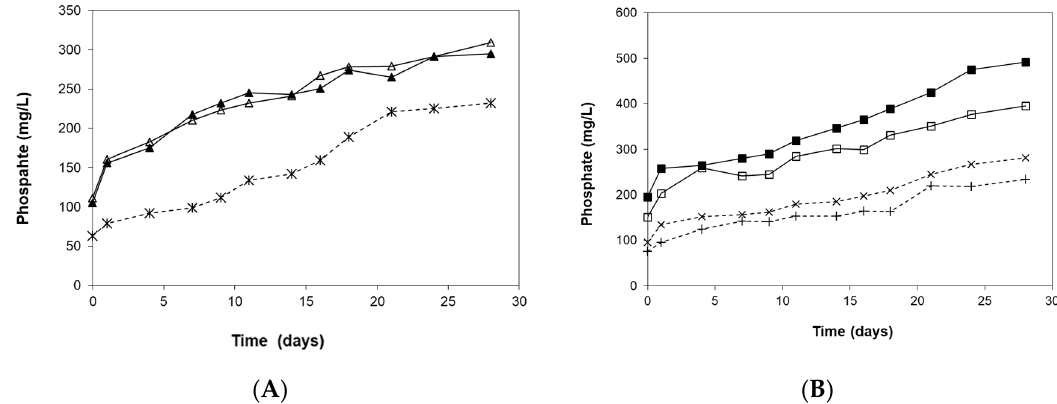
Figure 2. Solubilization of phosphate in the bioreactors subjected to reductive dissolution ( A ) under anoxic conditions using A. ferrooxidans sparged with (i) OFN (closed triangles) and (ii) OFN enriched with 10% of CO 2 (open triangles). ( B ) Under aerobic conditions using A. thiooxidans at (i) pH 0.9 (closed squares) and (ii) pH 1.2 (open squares). Dashed lines show the solubilization of total iron in the non-inoculated reactors at pH 1.8( ), 1.2 (+), and 0.9 (x).